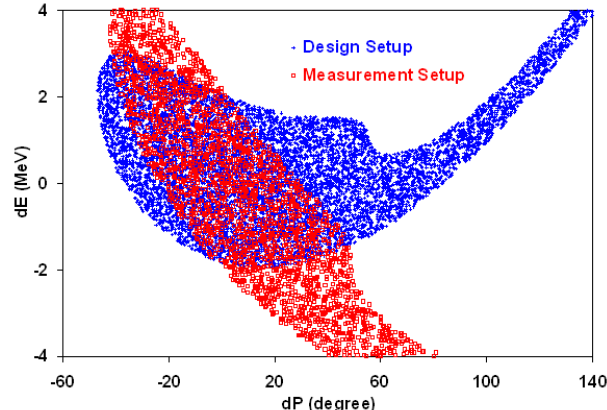
FIG. 2. (Color) Model predicted change in downstream cavity phase without rephasing the superconducting linac when (1) only the first cavity phase is shifted by 10 degrees (Cav1_phase), and (2) the injection energy is changed by 0.6 MeV by adjusting the upstream cavity one phase